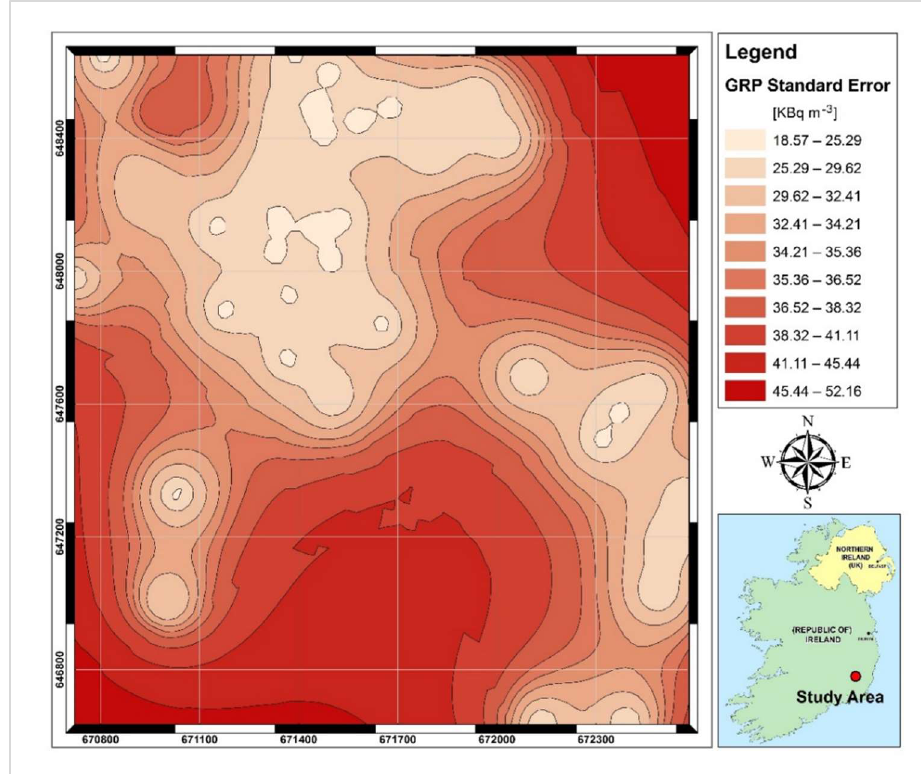
Figure 9. Predicted Geogenic Radon (GRP) concentrations.